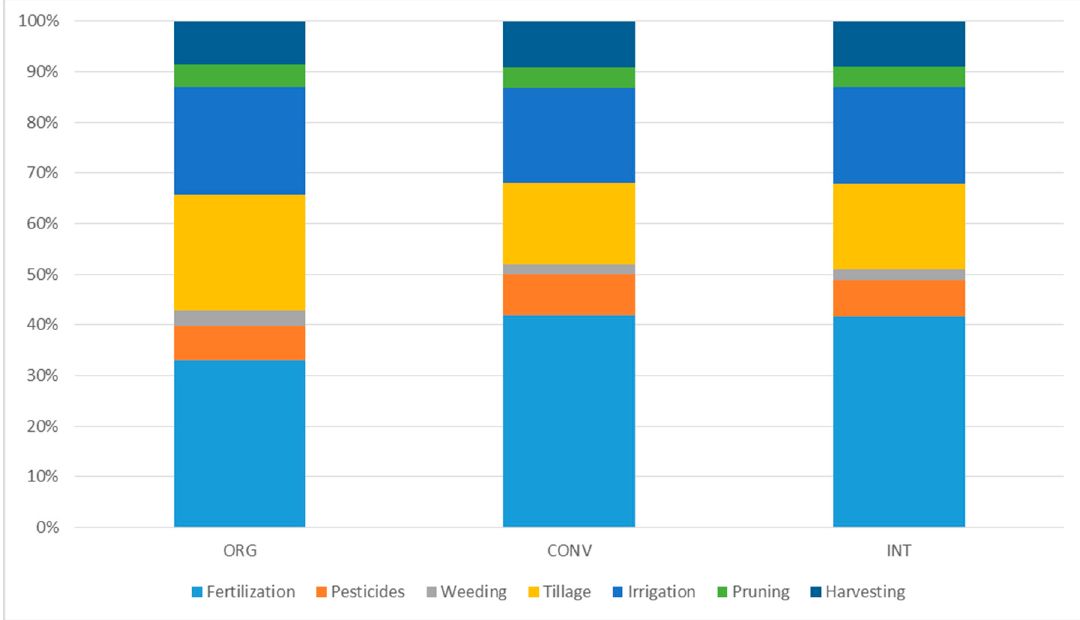
Figure 6. Contribution to Cumulative Energy Demand by agricultural operations.